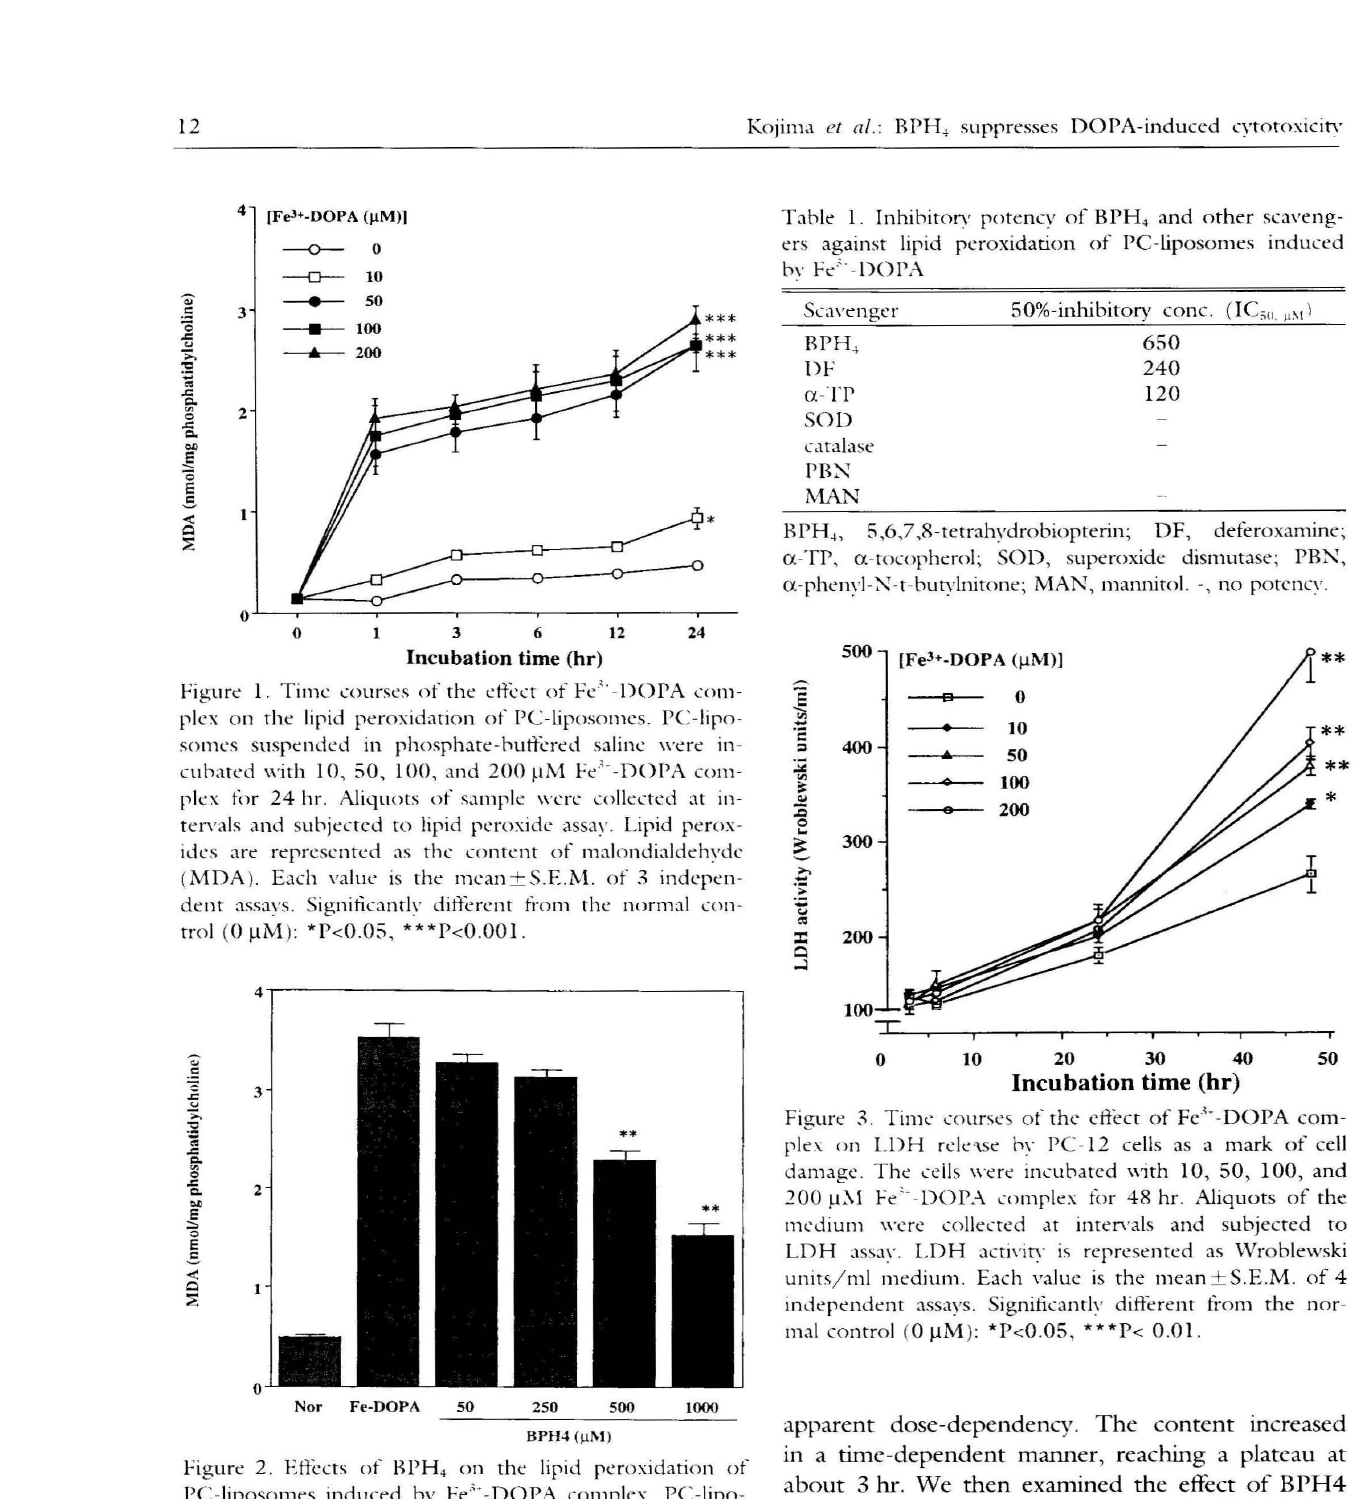
650 11M, 240 11M and 120 11M, respectively. SOD (1000 U/ ml), catalase (200 U/ml), PEN (100 11M), and MAN (10 mM) were